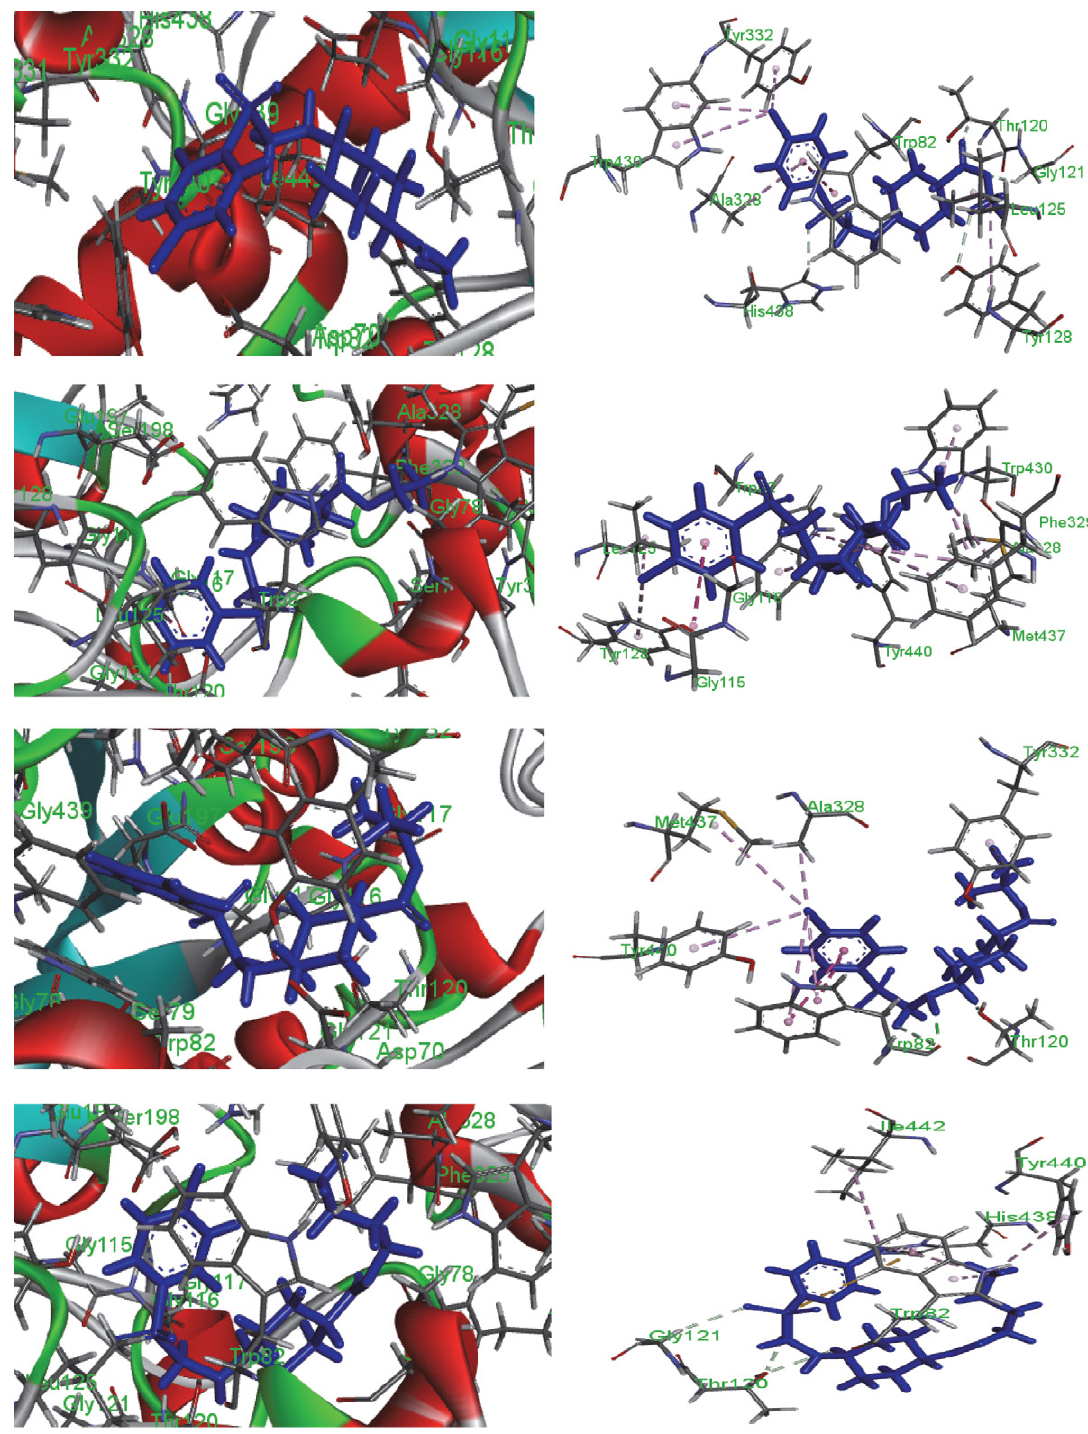
Figure 8. Best docking-poses of the synthesized compounds in the binding site of